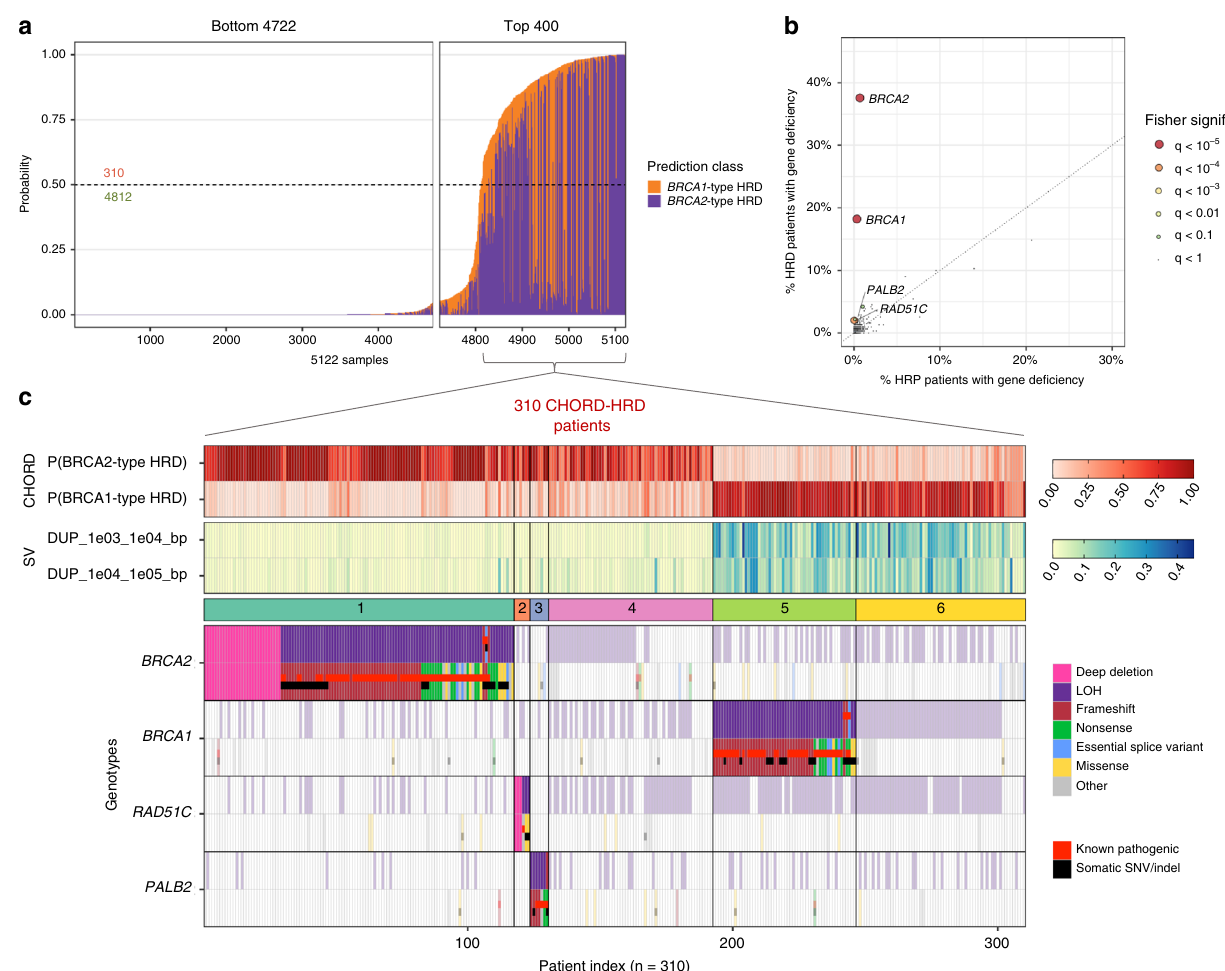
Fig. 3 The genetic causes of HRD in patients from the HMF and PCAWG datasets. a The bar plot shows the probability of HRD for each patient (total bar height) with each bar being divided into segments indicating the probability of BRCA1 -type HRD (orange) and BRCA2 -type HRD (purple). 310 patients were predicted HRD while 4812 were predicted HRP by CHORD. b A one-tailed Fisher ’ s exact test identi fi ed enrichment of BRCA1 ( q = 9.4e-51), BRCA2 ( q = 4.8e-101), RAD51C ( q = 5.6e-5) and PALB2 ( q = 0.02) biallelic inactivation in CHORD-HRD vs. CHORD-HRP patients (from a list of 781 cancer and HR related genes). Each point represents a gene with its size/color corresponding to the statistical signi fi cance as determined by the Fisher ’ s exact test, with axes indicating the percentage of patients (within either the CHORD-HRD or CHORD-HRP group) in which biallelic inactivation was detected. Multiple testing correction was performed using the Hochberg procedure. c Biallelic inactivation of BRCA2 , RAD51C and PALB2 was associated with BRCA2 -type HRD, whereas only BRCA1 inactivation was associated with BRCA1 -type HRD. Top: BRCA1 - and BRCA2 -type HRD probabilities from CHORD. Middle: